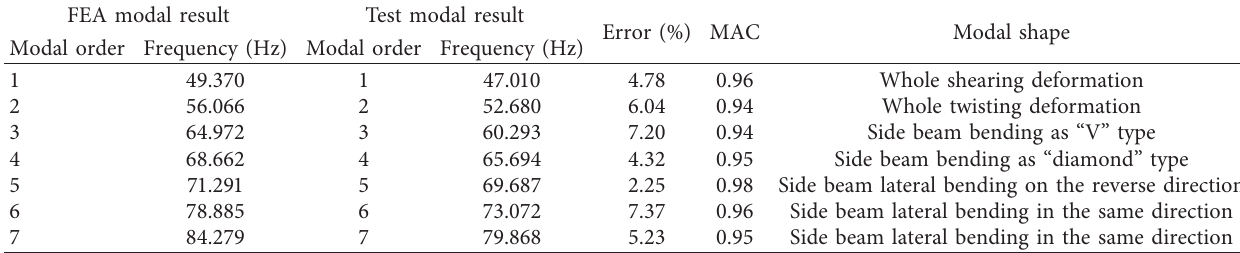
Table 1: Modal analysis of FEM and EMA results. FEA modal result Test modal